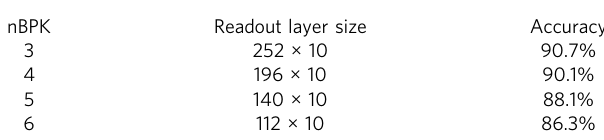
Table 3 Results of the MNIST recognition while increasing the number of bits processed in the temporal kernel, showing that as nBPK increased, both the size of the used readout layer and the recognition accuracy